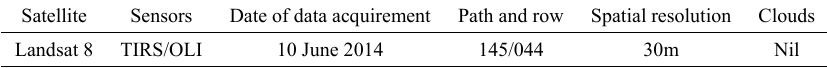
Table 1: Properties of Landsat satellite image used. Satellite